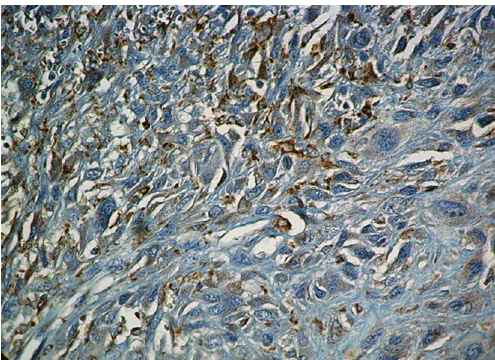
Figure 3: Many cancer cells are moderately to strongly positive to CD68 (DAB/Hematoxylin, ×